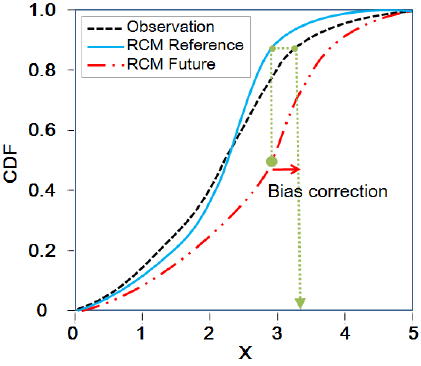
Figure 1. Quantile mapping for bias correction.